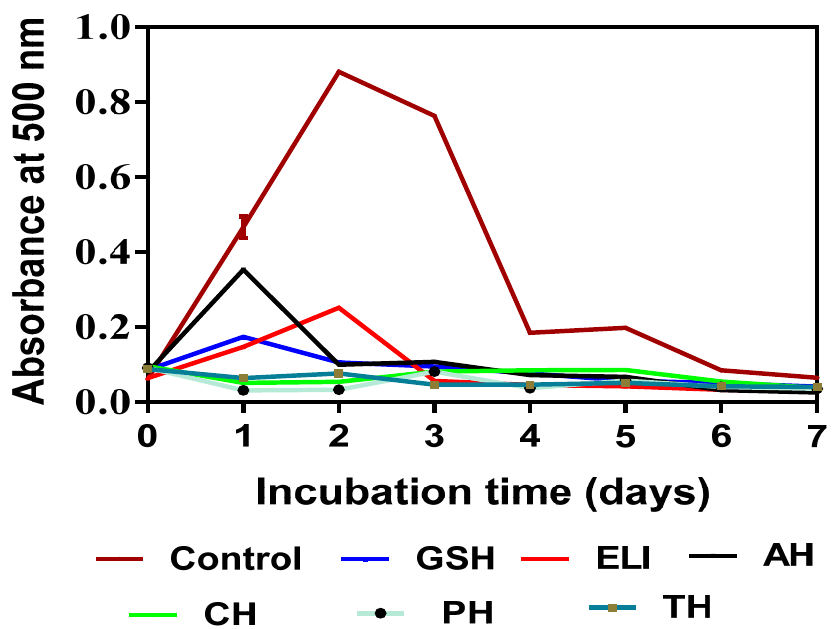
Figure 4. Inhibition of linoleic acid peroxidation by glutathione (GSH as control), eggplant leaf protein isolate (ELI) and protein isolate (ELI) and enzymatic protein hydrolysates alcalase (AH), chymotrypsin (CH), pepsin enzymatic protein hydrolysates alcalase (AH), chymotrypsin (CH), pepsin (PH) and trypsin (TH). (PH) and trypsin